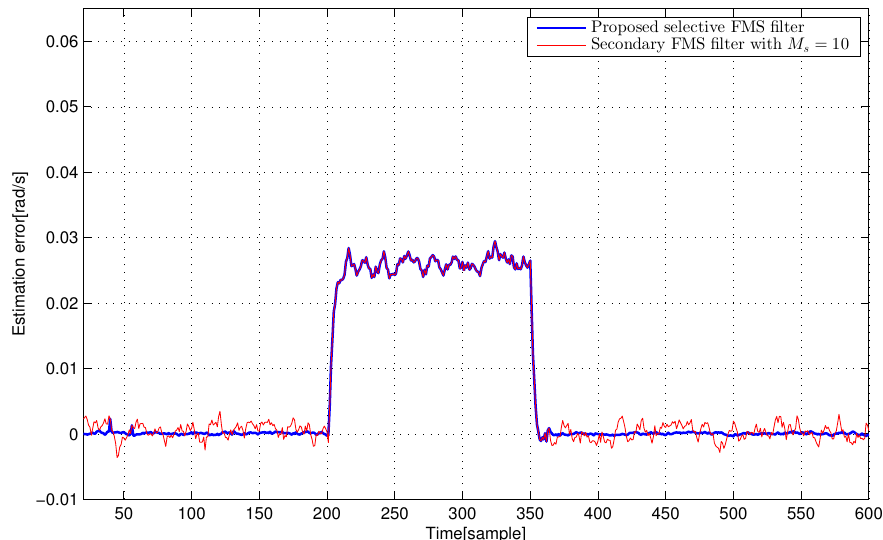
Figure 10. Estimation errors of the proposed selective FMS and secondary FMS filters for the electric motor